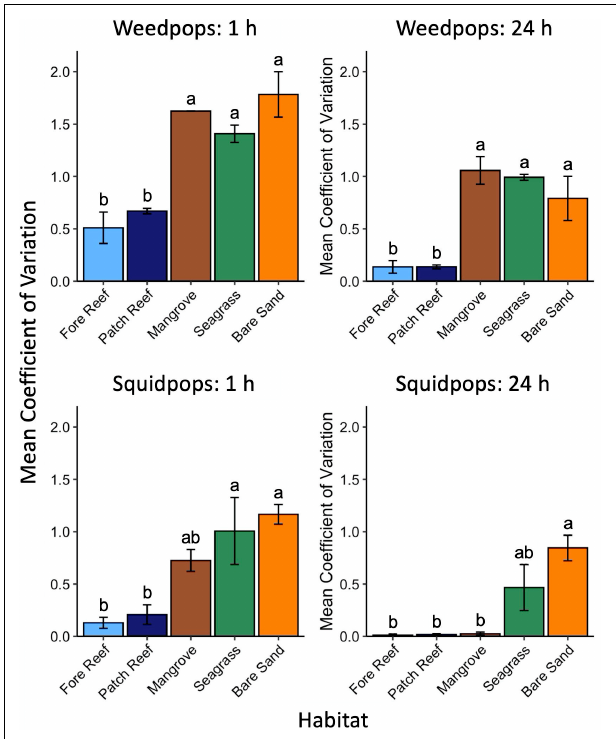
FIGURE 2 | Mean coefficients of variation for sites ( n = 3) within each habitat over 5 years ( ± 1 S.E.). Differing letters denote significant differences between values.